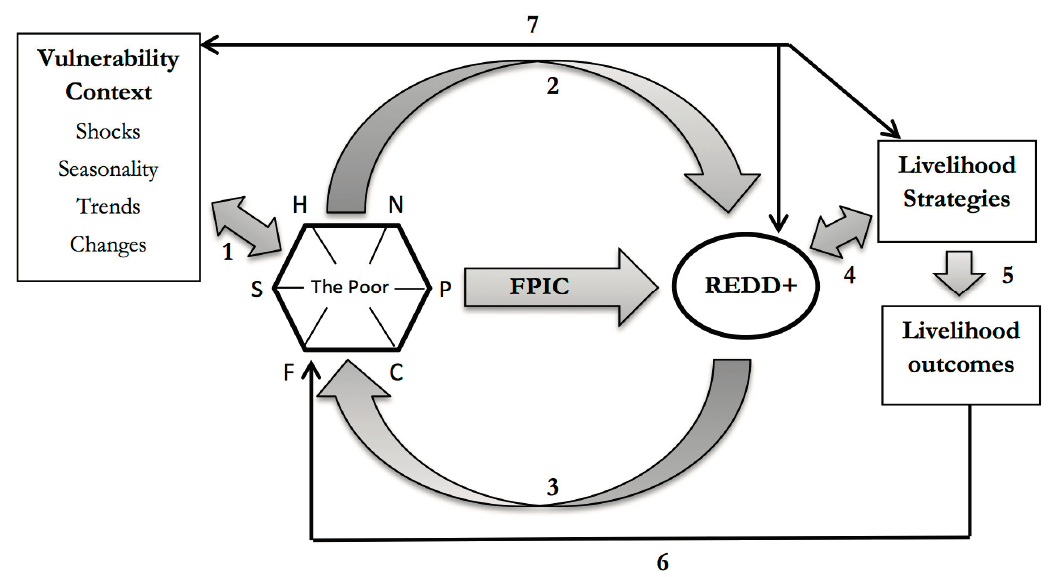
Figure 1. Applied REDD+ livelihoods